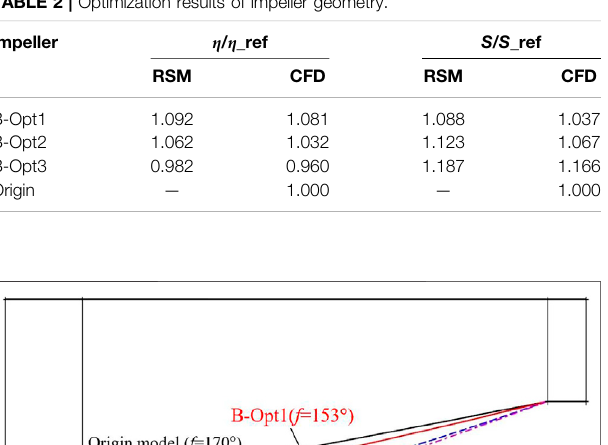
TABLE 2 | Optimization results of impeller geometry.